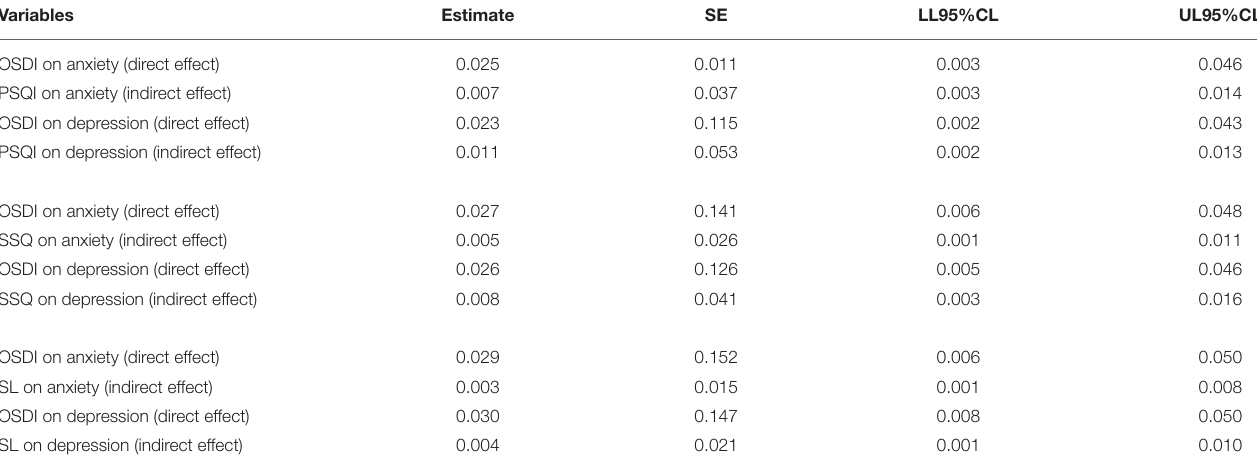
TABLE 6 | Bootstrap results for the mediation